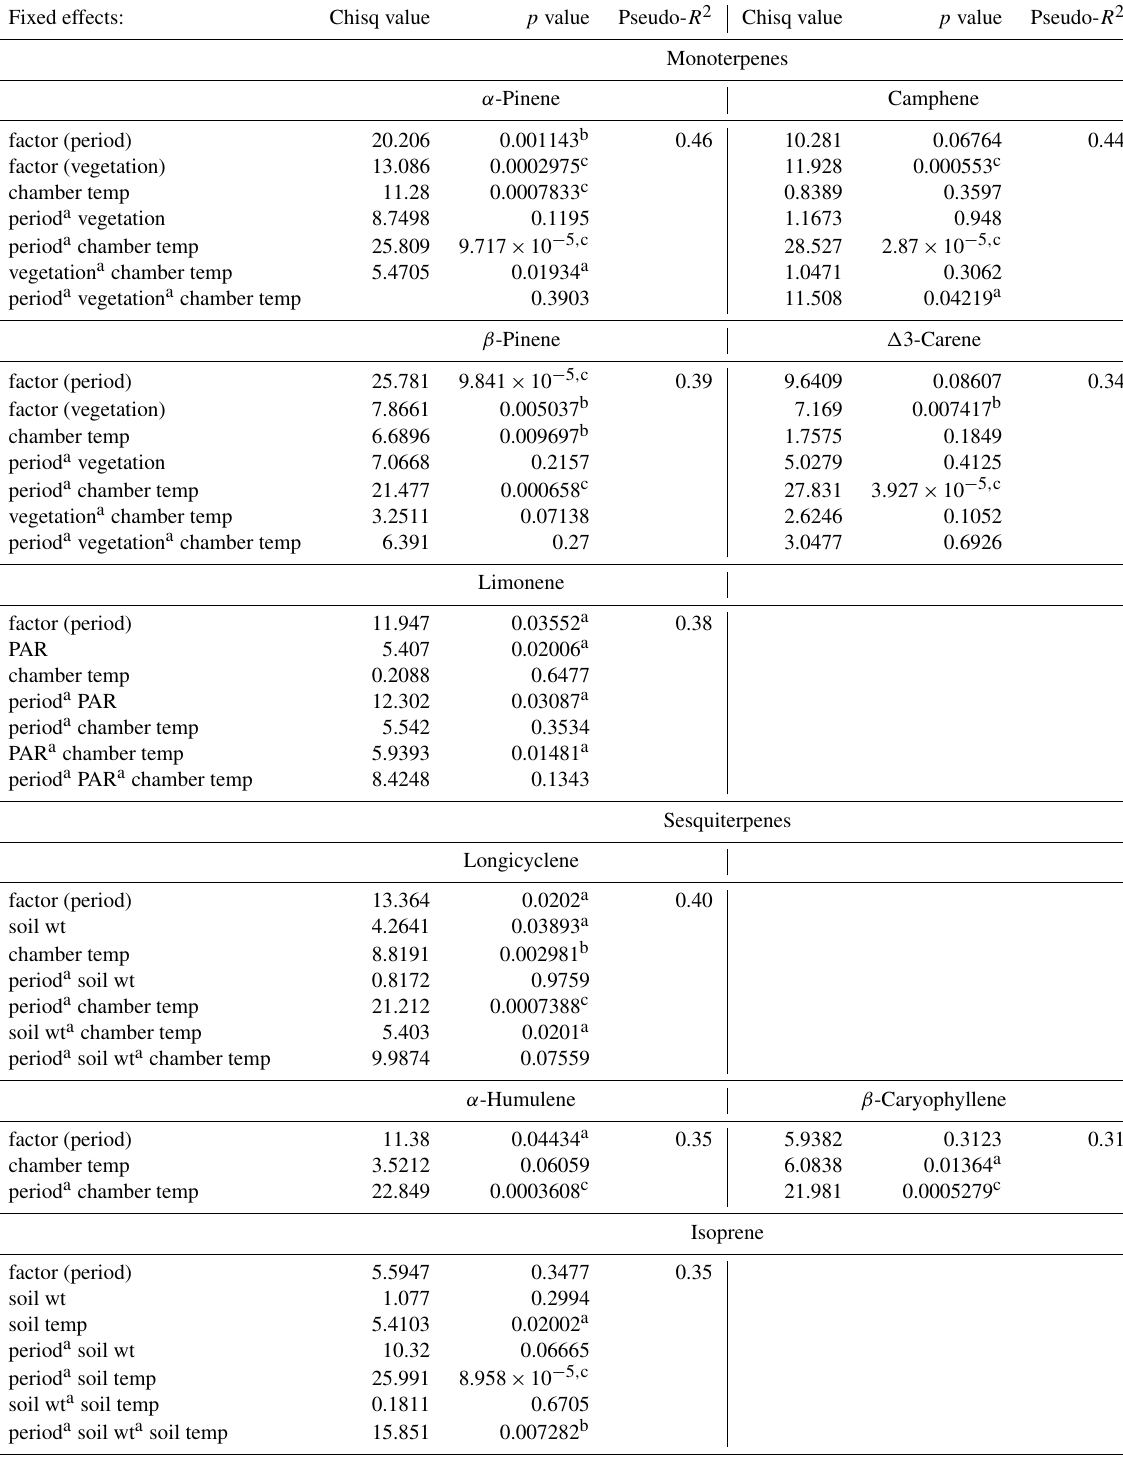
Table 6. Results from the mixed-effect linear models, testing the factors impacting isoprenoid fluxes from boreal forest soil ( N [all treat- ments] = 163, N [plot] = 36, N [site] = 3). Tested effects: period (1–6), vegetation ( ± ), chamber temperature (chamber temp), soil temper- ature (soil temp), PAR, soil water content (soil wt), and the interactions of these. Random effects were related to trenching plot number and trenching site. Pseudo- R 2 was calculated based on Nakagawa and Schielzeth (2013), and Johnson